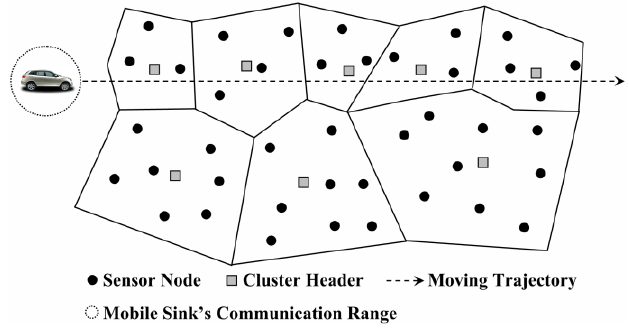
Figure 2. Unequal cluster formation in MobiCluster [21].